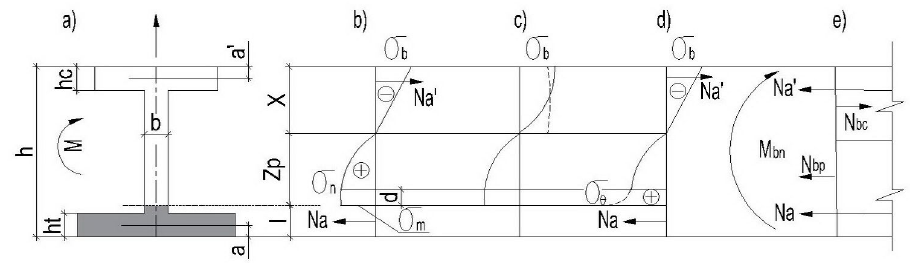
Figure 1: Stress distribution in the cross section of a curved beam with crack length l and compression zone height x : (a) beam cross section; (b,c) diagrams of nominal stresses in the beam section; (d) stress diagrams at the crack tip; (e) forces acting in the section. The crack zone is marked in